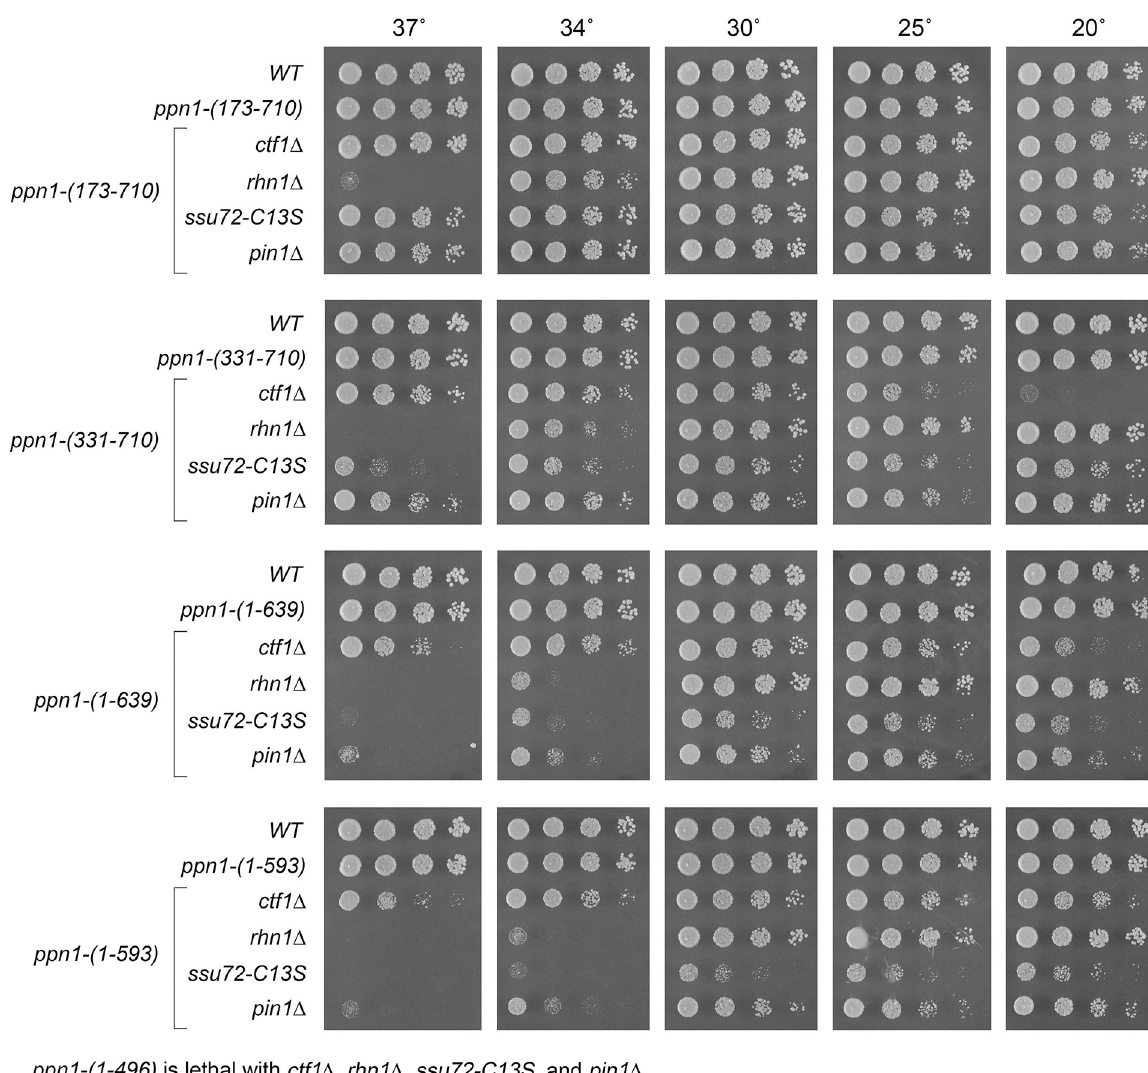
Fig 8. Activity of Ppn1 truncations in 3’ processing/termination mutant backgrounds. S . pombe strains bearing the indicated ppn1 truncation alleles in combination with CPF subunit, Rhn1, or Pin1 mutants as specified were spot-tested for growth on YES agar at the indicated temperatures. The ppn1-(1–496) allele was synthetically lethal with ctf1 Δ , rhn1 Δ , ssu72-C13S , and pin1 Δ